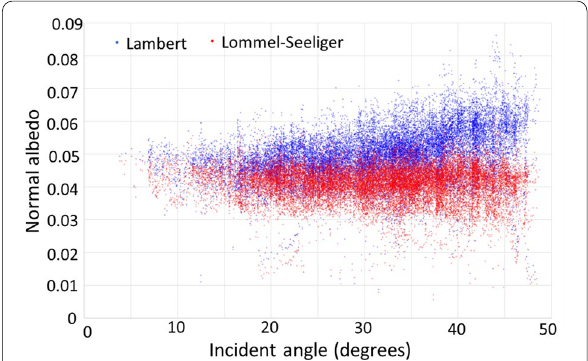
Fig. 12 ρ and incident angle for the two reflectance laws; the Lambert (blue) and the Lommel–Seeliger (red). The 31,647 data are shown for each law. These data were obtained on 20 July 2018 (Table 3) and were selected following the procedures described in Chapter 4. In this selection, the data for incident angles higher than 50° were excluded, because the widths of D R are longer than 90 ns (See Estimation of E obs from D R